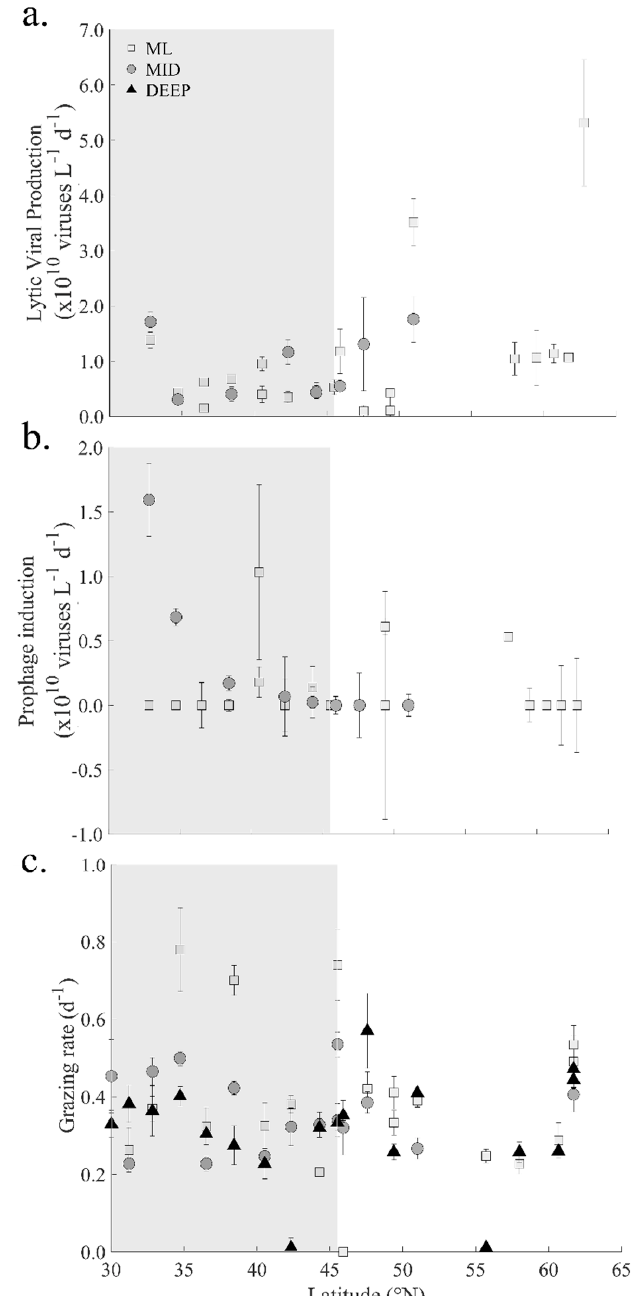
Figure 4. Average rates of viral and grazing activity within prokaryotes communities in the Northeast Atlantic during the summer STRATIPHYT cruise. Daily rates of ( a ) lytic viral production (VP), ( b ) Mitomycin C prophage induction (VPC), and ( c ) microzooplankton grazing. Rates were obtained from three separate depths: the mixed layer (ML; 15 m), below the mixed layer (MID; 25–85 m), which included the deep ‐ chlorophyll maximum where present (DCM; 47–85 m; defined by the presence of a subsurface peak in the vertical profile of Chl a autofluorescence), and deep (DEEP; 100–225 m). Error bars represent standard error ( n = 3). Gray shaded area represented the latitudinal range of stations with a DCM present.